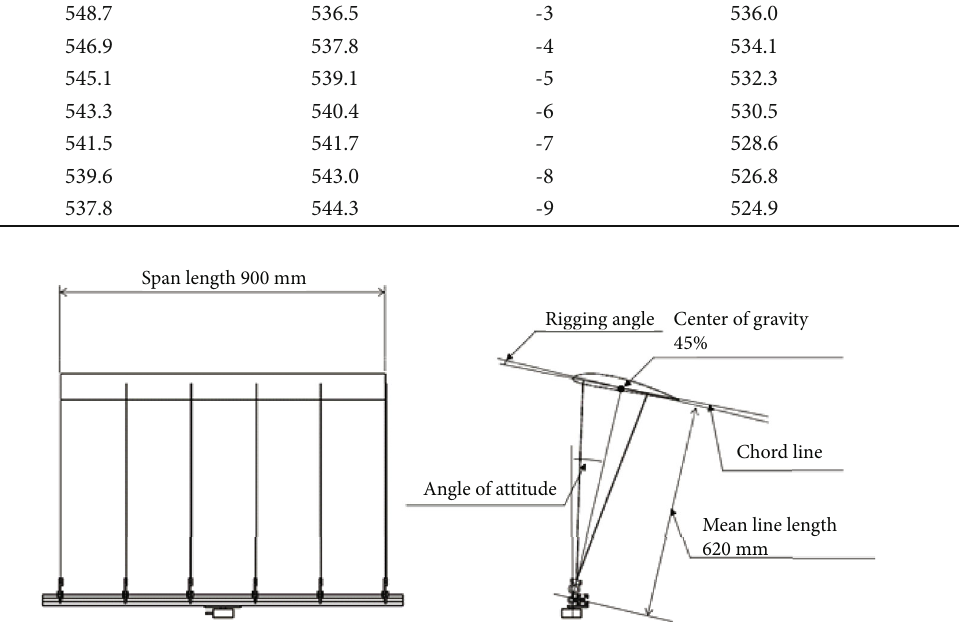
Figure 12: Details of the wind tunnel test model.